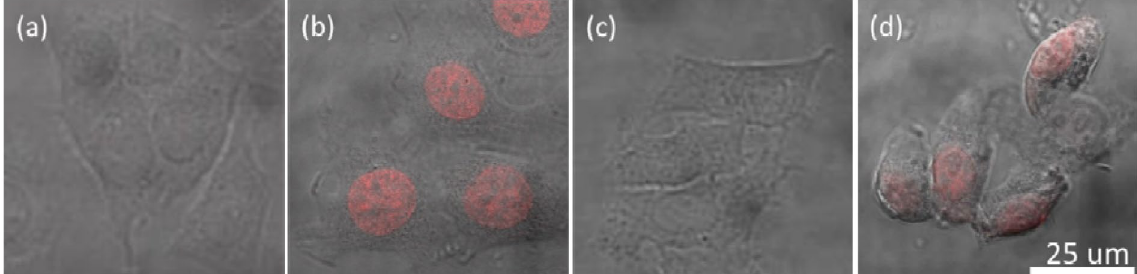
Figure 6. Needle-shaped PLGA-PEG NPs induced DNA fragmentation by TUNEL assay. Confocal images (merged with transmitted channel) of HepG2 cells (stained with TUNEL Red) after their being fed with ( a ) &